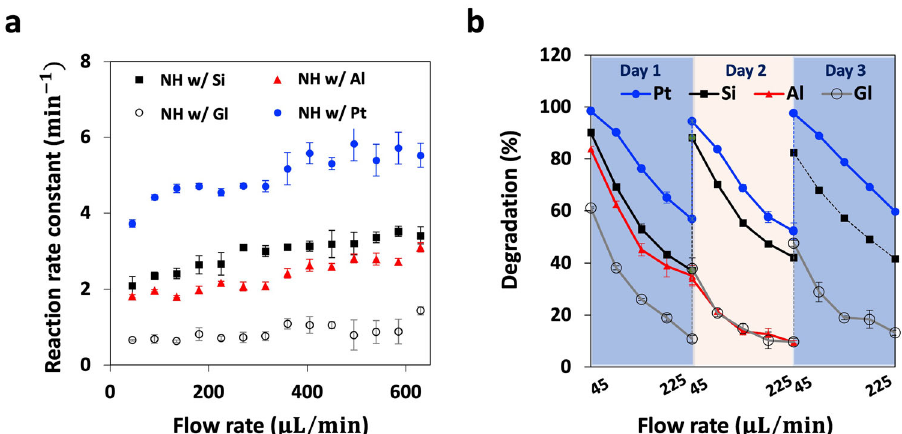
Fig. 3 Water puri fi cation capacities of NH reactors using different base substrates. a Reaction rate constant of the reactors with TiO 2 NHs deposited on the platinum (Pt), silicon (Si), aluminum (Al), and glass (Gl) substrates at different fl ow rates. b Re-usability of the NH reactors. The degradation ef fi ciencies of the NH reactors with Pt, Si, Al, and Gl substrates were measured repeatedly on different 3 days at various fl ow rates. The error bars represent the standard deviations of at least six times repeated